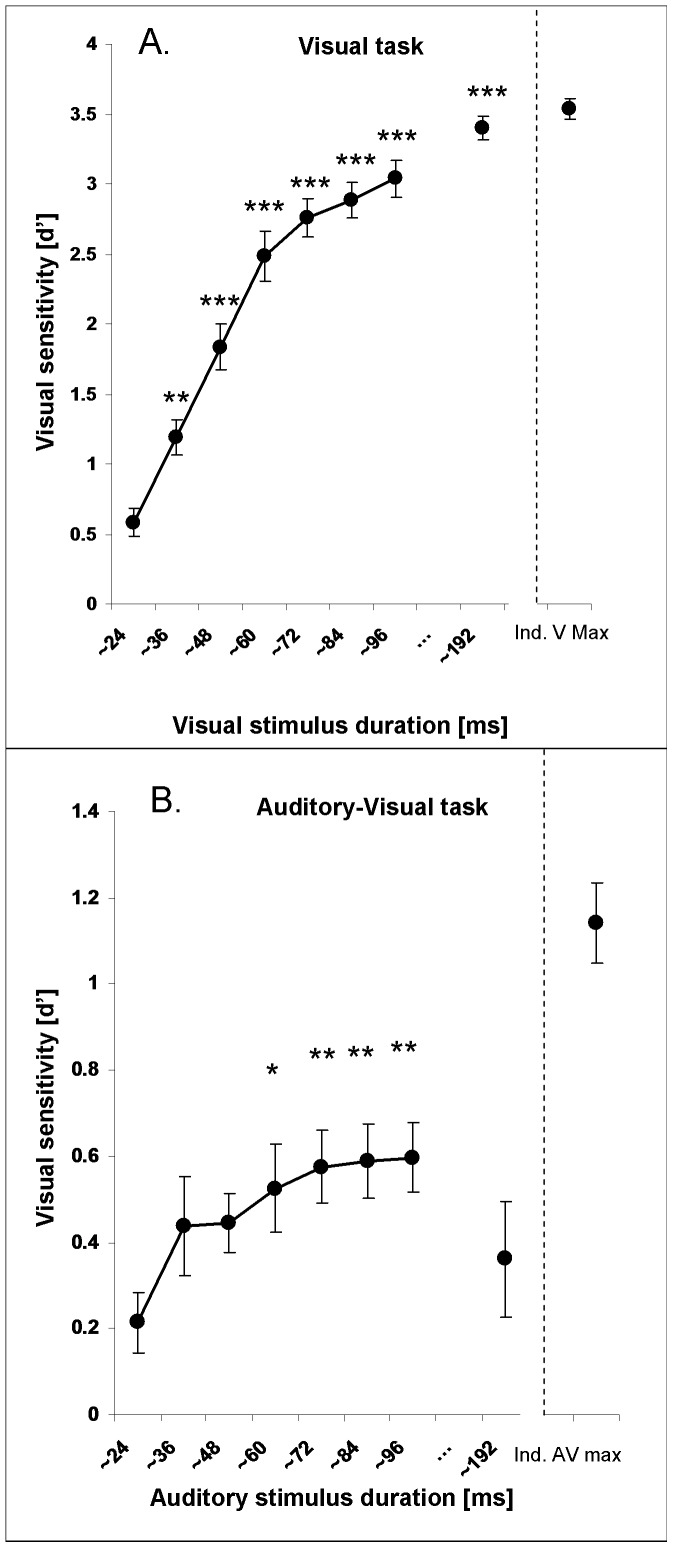
Effect of stimulus durations on visual sensitivity.Mean visual discrimination sensitivity (d’, SEM indicated) for varying visual stimulus durations (2A, upper panel) and for visual stimuli of fixed duration (∼24 ms), paired with auditory stimuli of varying durations (2B, lower panel). Asterisks indicate significant enhancement in visual sensitivity relative to the shortest (audio-) visual stimulus (leftmost data point in figures 2A and 2B) (* p<.05, ** p<.01 ***p<.001; all Bonferroni corrected). The rightmost data point represents the average maximum of the visual sensitivity enhancement across participants in the visual task (namely ‘Ind. V max’, Figure 2A) and audiovisual task (namely ‘Ind. AV max’, Figure 2B).